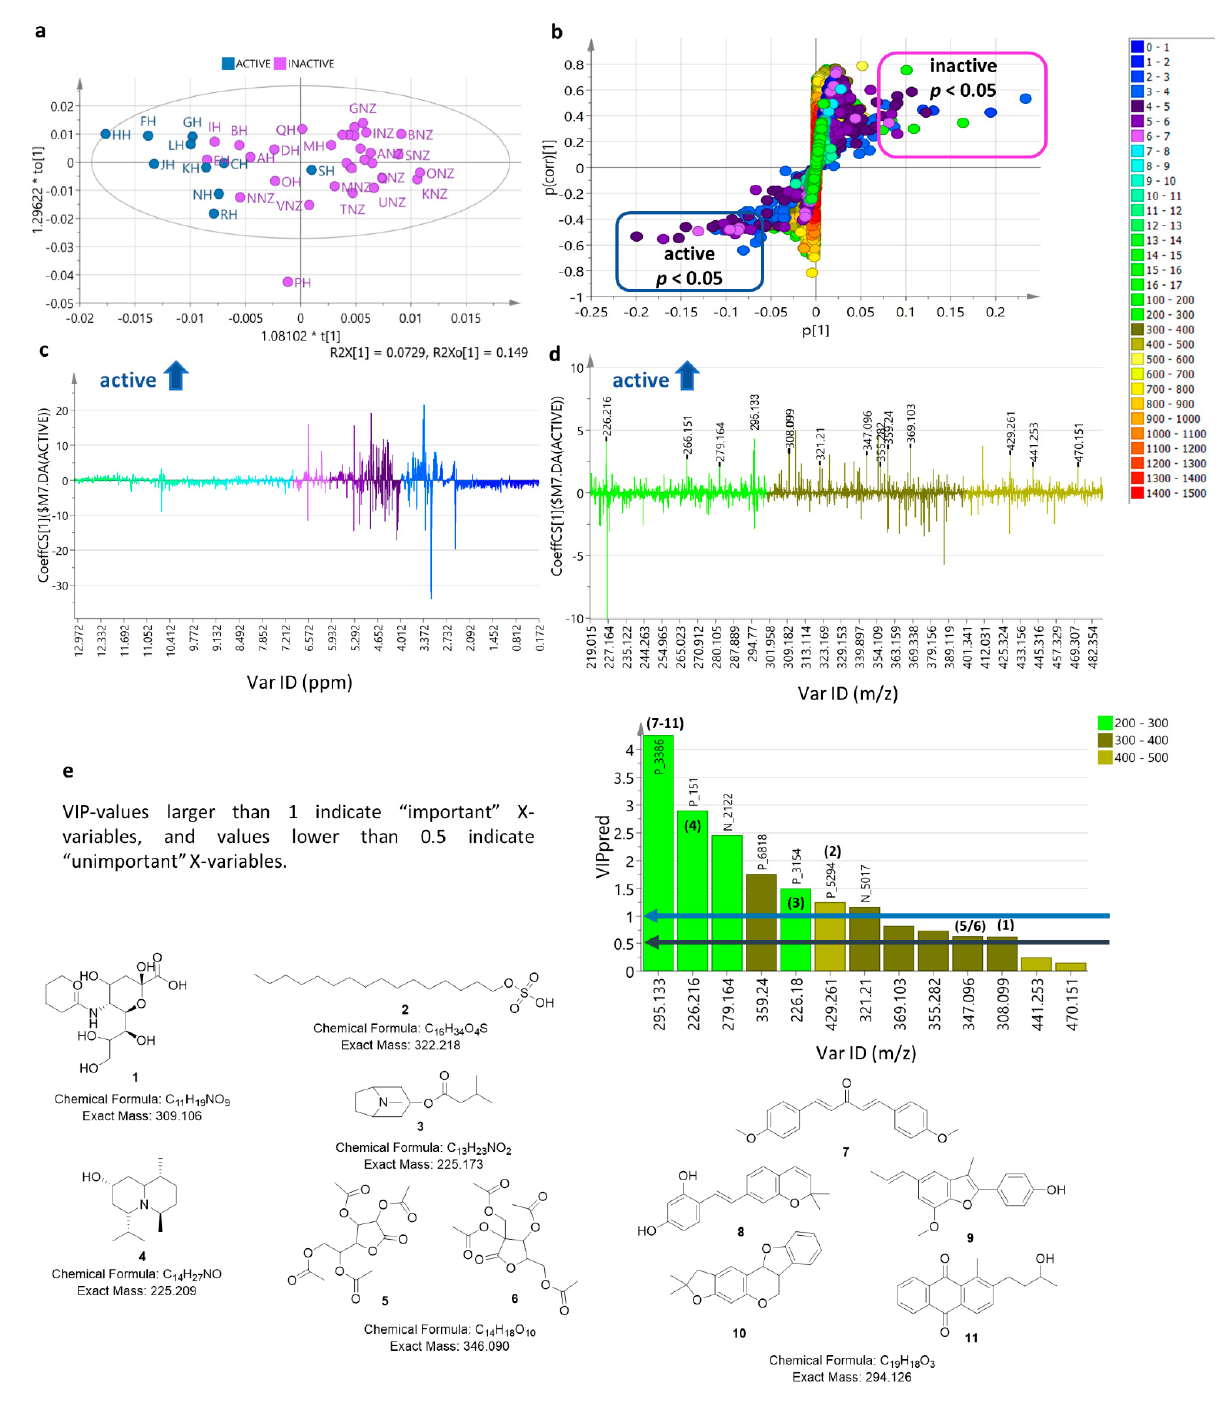
Figure 9. OPLS-DA model for bioactivity of honey samples against ZR75. ( a ) Scores plot of active versus inactive samples. ( b ) S-loadings plot pinpointing the putative bioactive metabolites in active extracts. ( c ) Coefficient plot indicating the ppm chemical shifts for functional groups of bioactive metabolites as shown on the positive phase of the Y axis. ( d ) Coefficient plot showing discriminating ion peaks m / z for bioactive samples, where labelled peaks have p < 0.05 as listed under Table 2c. ( e ) VIP plots and dereplicated structures of ion peaks for the bioactive variable features. Blue arrow indicates threshold for metabolites with VIP values > 1.0 while black arrow designates compounds with VIP values < 0.5. Color codes on S-plots are indicated by their chemical shifts in ppm values from 0 to 17 ppm and ion peaks at m / z from 150 to 1500 Da.